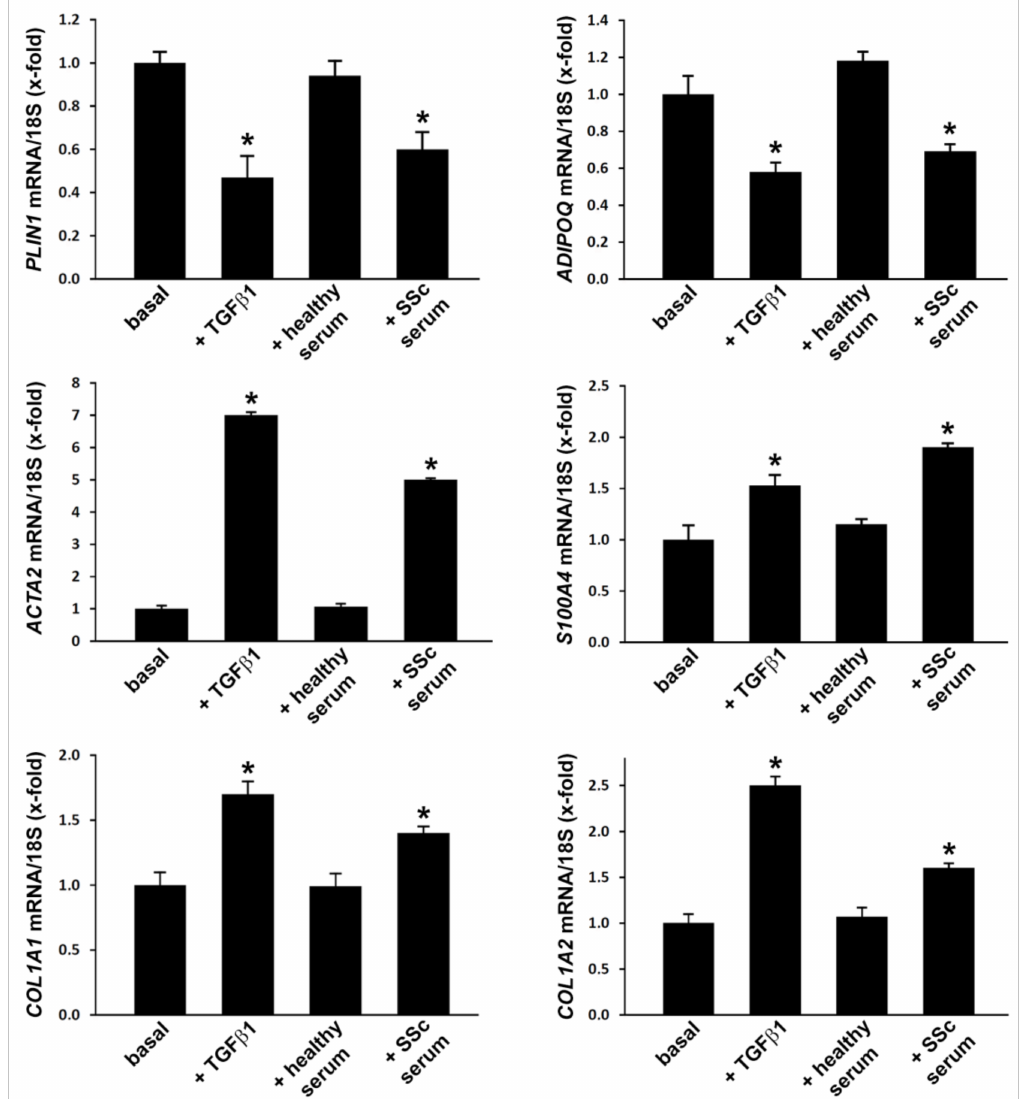
Figure 2. Treatment with systemic sclerosis (SSc) serum induces changes in gene expression levels of adipocytic and mesenchymal / myofibroblast markers in normal human adipose-derived stem cells (ADSC). ADSC were treated for 72 h with recombinant human transforming growth factor- β 1 (TGF β 1; 10 ng / mL), 10% serum from healthy individuals ( n = 6) or 10% serum from patients with early di ff use cutaneous SSc ( n = 6) and subsequently assayed for mRNA expression levels of PLIN1 (perilipin), ADIPOQ (adiponectin), ACTA2 ( α -smooth muscle actin), S100A4 (fibroblast-specific protein-1), COL1A1 and COL1A2 ( α 1 and α 2 chains of type I collagen, respectively) by quantitative Real-Time PCR. 18S ribosomal RNA was measured as an endogenous control for normalization. For each gene, the mRNA expression in basal cells was set to 1; the other results are expressed as x-fold increase / decrease over basal response. Bars represent the mean ± SEM. Results are representative of three independent experiments performed with three ADSC lines. Statistical analysis was carried out with Student’s t -test. * p < 0.001 vs. basal and healthy